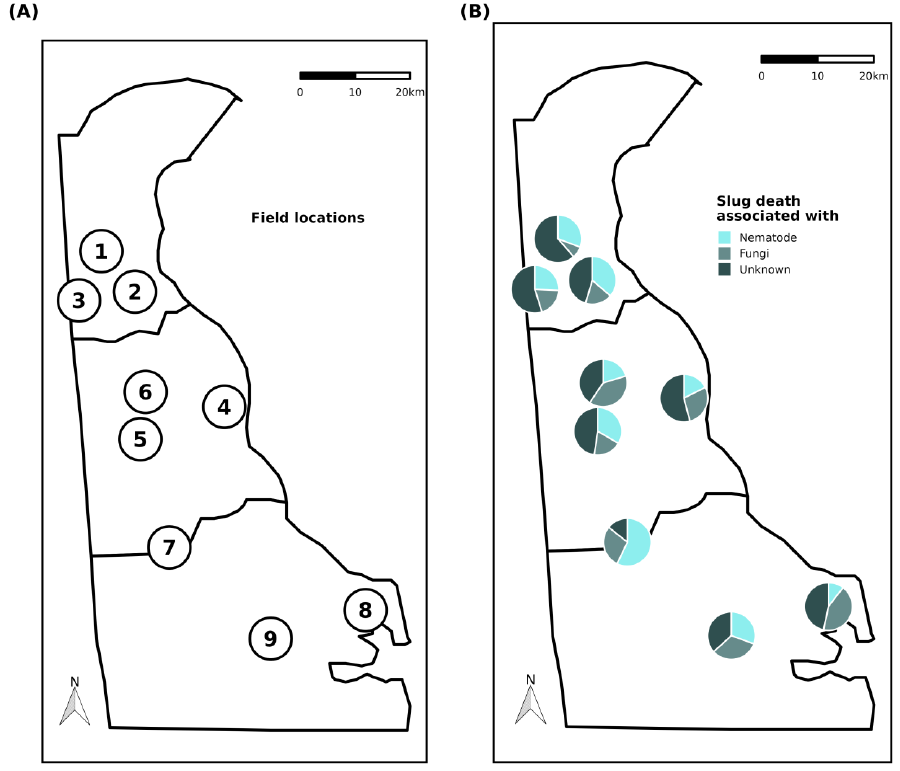
Figure 5. ( A ) Geographical locations of the surveyed fields across Delaware. Details on the field conditions are provided in Table 1. ( B ) Slug death associated with the presence of nematodes, fungi, or unknown causes at the different surveyed sites. Pie charts illustrate the proportion of slug death associated with the different factors measured among all individuals dead within 4 weeks after capture (4 traps per field and 4 sampling